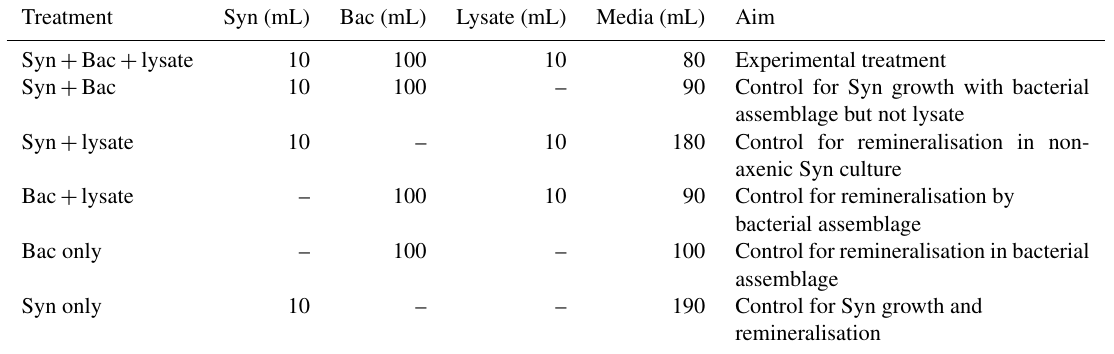
Table 1. Treatments in the laboratory experiment to examine increase in Synechococcus abundance (Syn), in the presence of bacterial lysate from Vibrio PWH3a (lysate), and an environmental bacterial assemblage (Bac). Treatment Syn (mL) Bac (mL) Lysate (mL) Media (mL)